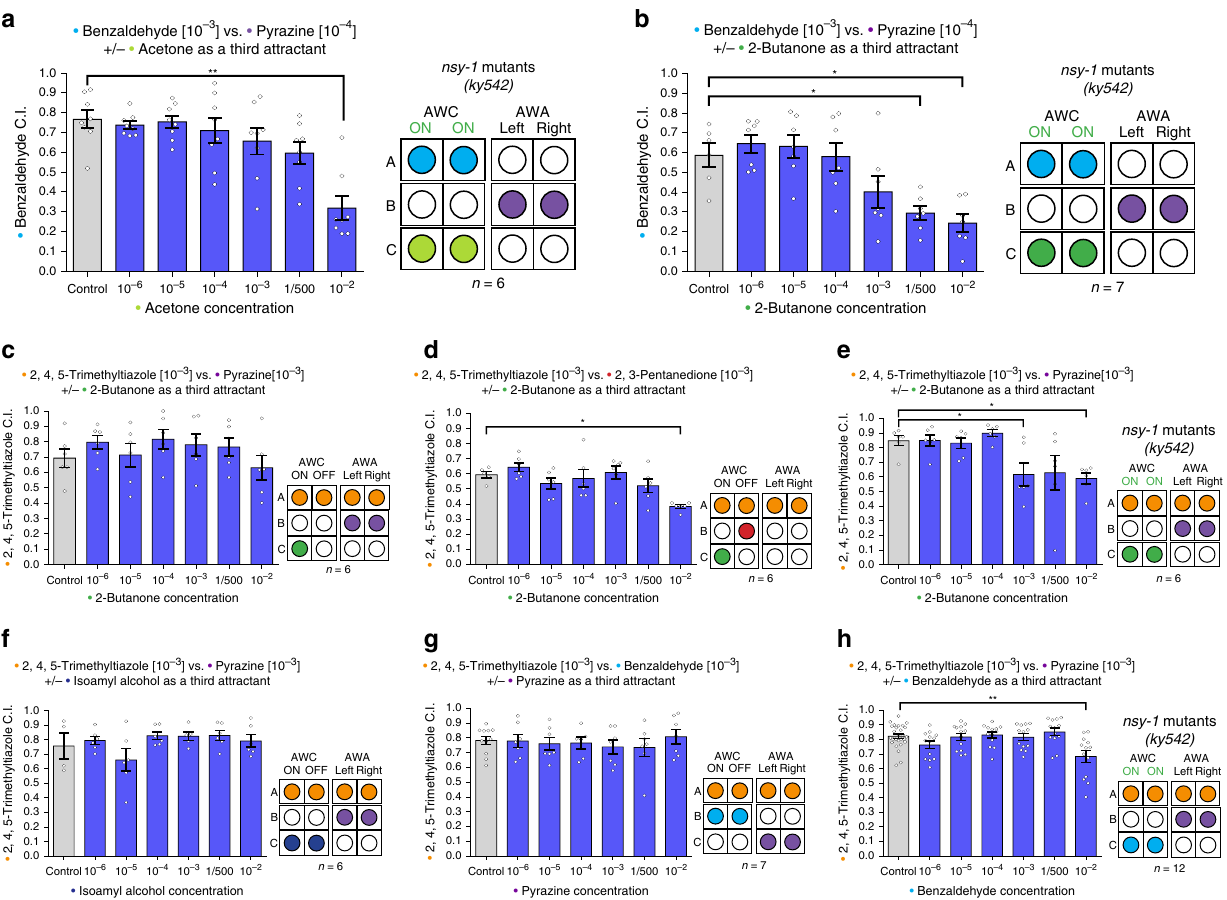
Fig. 3 The AWC ON neuron makes the worm vulnerable to IIA violations. a The in fl uence of acetone as a third attractant on the relative preference between benzaldehyde and pyrazine, in AWC ON/ON mutant worms. (two-tailed Wilcoxon signed-ranks test, C = 10 − 2 : W = 1, q = 0.0018; n = 6). b The in fl uence of 2-butanone as a third attractant on the relative preference between benzaldehyde and pyrazine, in AWC ON / ON mutant worms. (two-tailed Wilcoxon signed-ranks test, C = 1/500: W = 2, q = 0.0141; C = 10 − 2 : W = 2, q = 0.0141; n = 7). c 2-butanone as a third attractant does not change the relative preference between 2,4,5-trimethylthiazole and pyrazine (two-tailed Wilcoxon signed-ranks test, n = 6). d The in fl uence of 2-butanone as a third attractant on the relative preference between 2,4,5-trimethylthiazole and 2,3-pentanedione (two-tailed Wilcoxon signed-ranks test, C = 10 − 2 : W = 0, q = 0.0258; n = 6). e 2-butanone as a third attractant changes the relative preference between 2,4,5-trimethylthiazole and pyrazine in AWC ON / ON mutant worms (two-tailed Wilcoxon signed-ranks test, C = 10 − 2 : W = 3, q = 0.0456; C = 1/500: W = 7, q = 0.1862; C = 10 − 3 : W = 0, q = 0.0132; n = 6). f Isoamyl-alcohol as a third attractant does not change the relative preference between 2,4,5-trimethylthiazole and pyrazine (two-tailed Wilcoxon signed- ranks test, n = 6). g Pyrazine as a third attractant does not change the relative preference between 2,4,5-trimethylthiazole and benzaldehyde (two-tailed Wilcoxon signed-ranks test, n = 7). h Benzaldehyde as a third attractant changes the relative preference between 2,4,5-trimethylthiazole and pyrazine (two-tailed Wilcoxon signed-ranks test, C = 10 − 2 : W = 60, q = 0.003; n = 12). Bars represent the C.I. of odor A. Error bars represent the standard error of the mean C.I. * q < 0.05, ** q < 0.01, *** q < 0.001, and **** q <